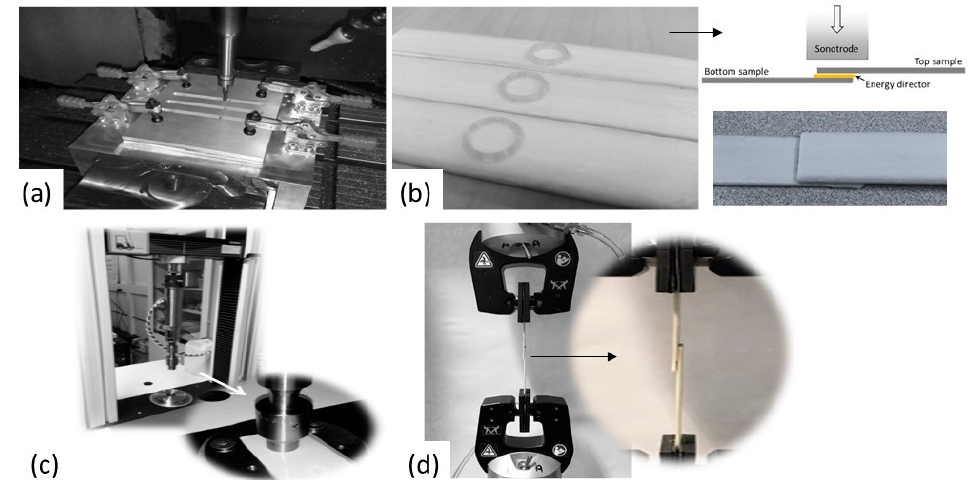
Figure 13. Welding process. ( a ) Milling of 2.5sPA6 and raw PA6 composite specimens, ( b ) deposition of 2.5sPA6 as an energy director on the specimens by FFF, ( c ) ultrasonic welding with cylindrical sonotrode and ( d ) mechanical test to evaluate weld strength.